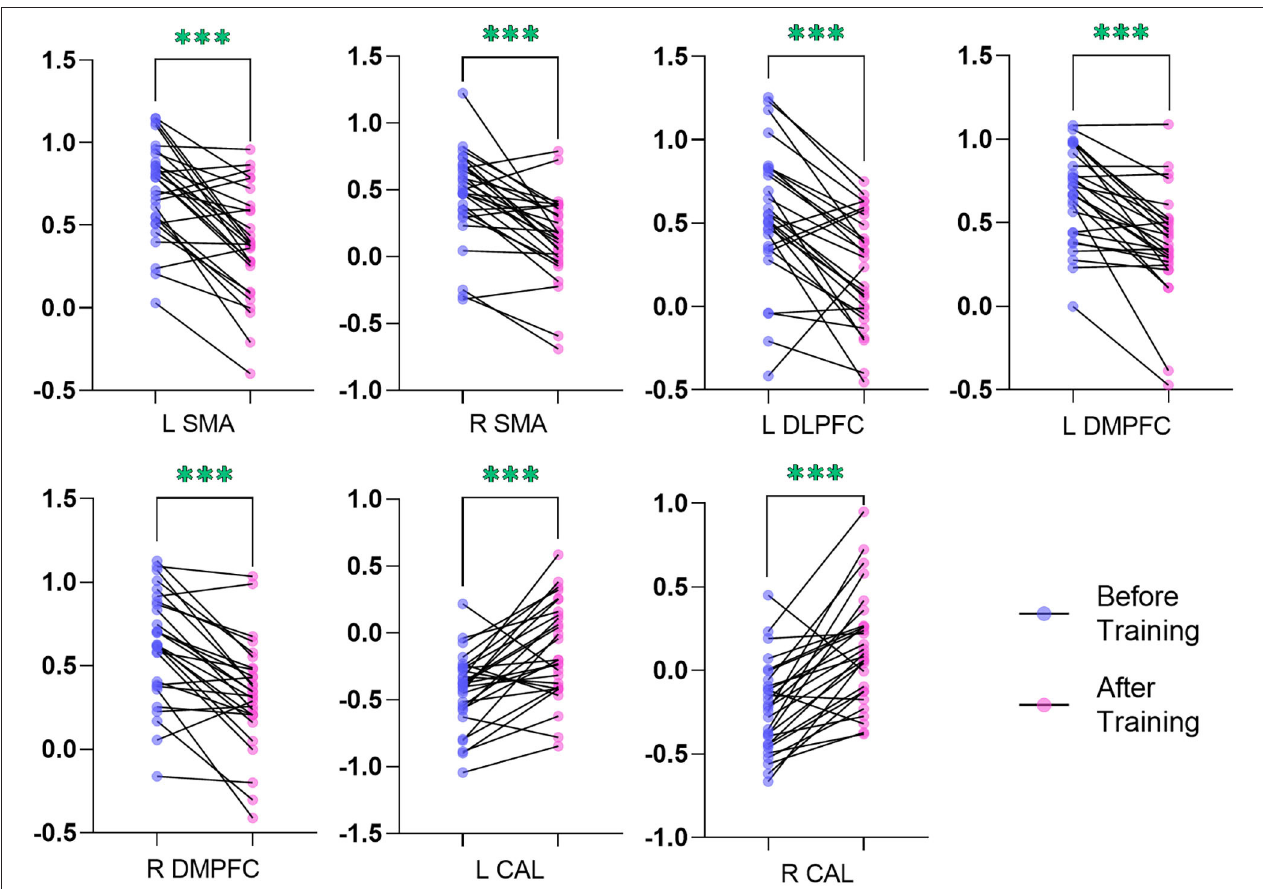
FIGURE 3 | Plot of the z-transform ReHo values in brain regions that exhibited altered ReHo. The blue dots (before training condition) and the pink dots (after training condition) indicated the mean values of ReHo in the different brain regions of all the subjects. L, left; R, right; ReHo, regional homogeneity; SMA, supplementary motor area; DLPFC, dorsal lateral pre-frontal cortex; DMPFC, dorsal medial pre-frontal cortex; CAL, cerebellum anterior lobe. ***indicates p <